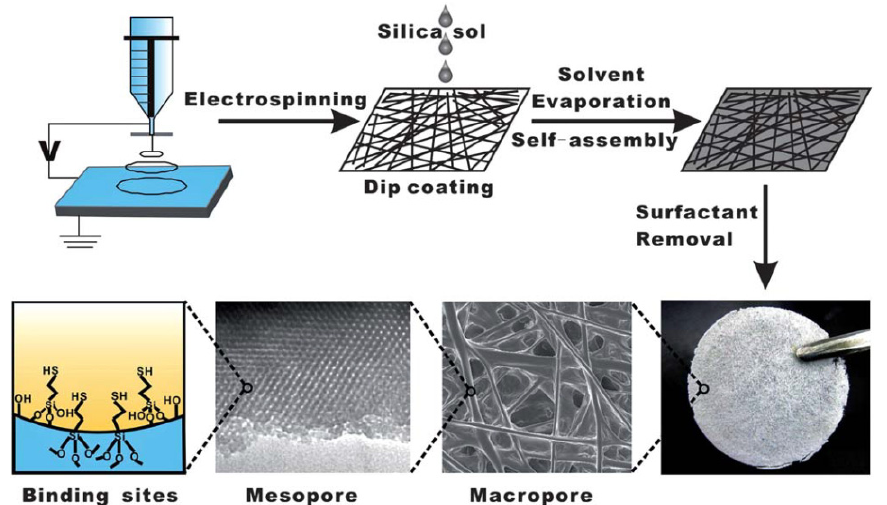
Figure 19. Schematic illustration of preparing thiol-functionalized membranes using electrospun nanofibrous mats as the skeleton. Reproduced with permission from [254]. Copyright 2012 The Royal Society of